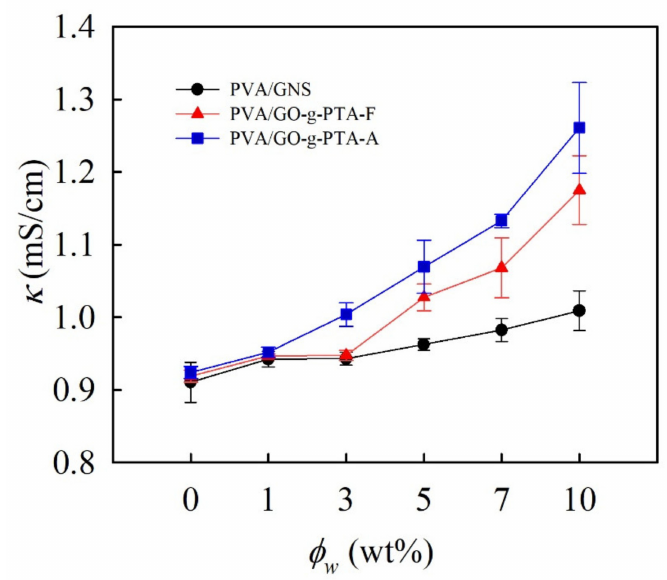
Figure 5. E ff ects of GNS, GO-g-PTA-F, and GO-g-PTA-A concentration on PVA solution conductivity at 25 ◦